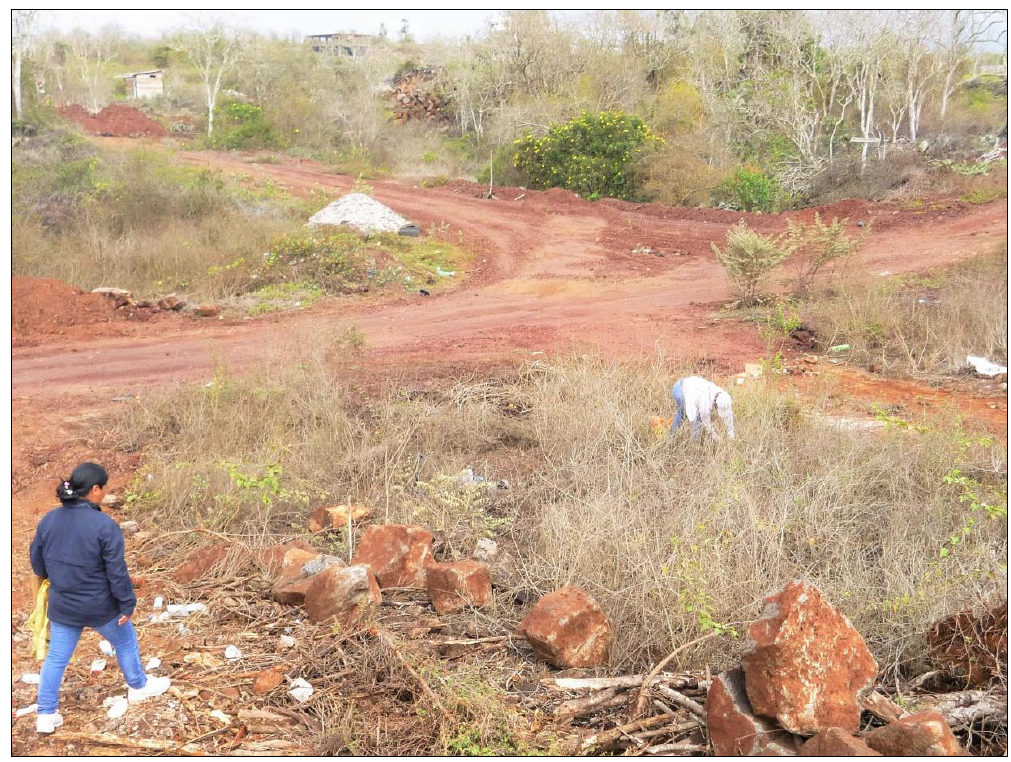
Figure 2. Celia and Luisa. Photo by author.